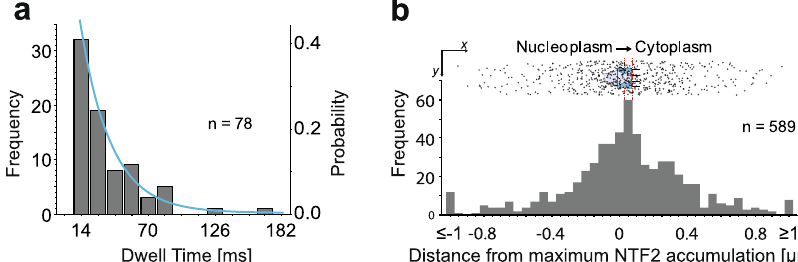
Fig. 4 Analysis of pre-60S export events. a Distribution of dwell times at the pore. The bar height indicates the frequency of the observation of the respective dwell times. The blue line indicates the best fi t of the probability distribution using an exponential decay model with one translocating species yielding an export duration of τ = 24 ± 4 ms. The total number of evaluated trajectories was n = 78. b Superposition of all export trajectories aligned to the transporting NPC. (Top) The trajectories were aligned to the transporting NPC (as indicated by the maximum of the eGFP-NTF2 signal) as the origin and then rotated such that the export direction coincided with the positive x axis. (Bottom) The number of pre-60S particle positions in a y axis region of ±100 nm was plotted in dependence on the location with regard to the average NTF2 accumulation. The maximum occurred at the position of the cytoplasmic ring of the NPC (red lines). The total number of single positions shown is n =